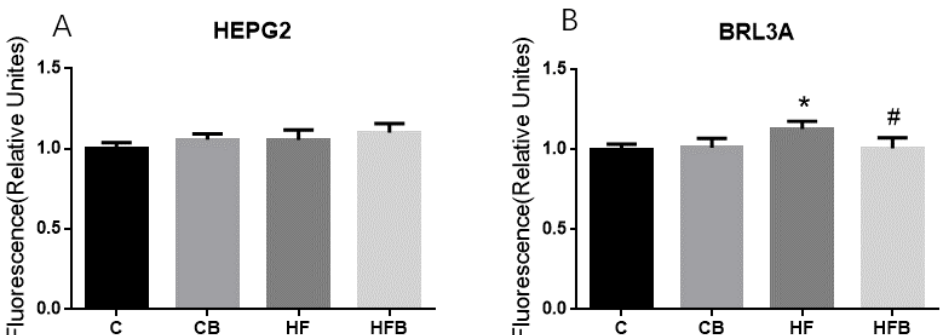
Figure 11. Effects of betaine and high-fat-medium on the cholesterol level of hepatic cells in vitro ( n = 6). ( A ) The level of total cholesterol in HepG2: BET, p = 0.019, FAT, p = 0.022, interaction, p = 0.763. ( B ) The level of total cholesterol in BRL3A: BET, p = 0.017, FAT, p = 0.008,